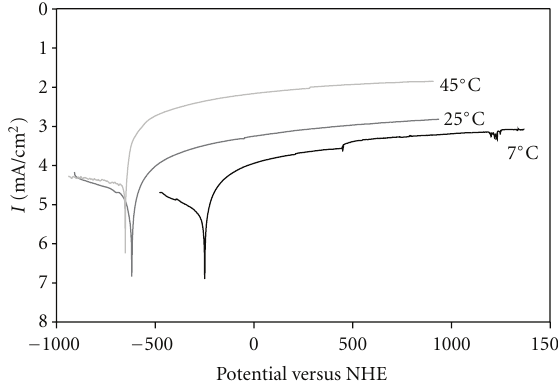
Figure 3: Potentiodynamic curves of Zn-10% Al-1.5% Cu at 0.3M NaCl solution for T = 25 ◦ C, 45 ◦ C, or 7 ◦